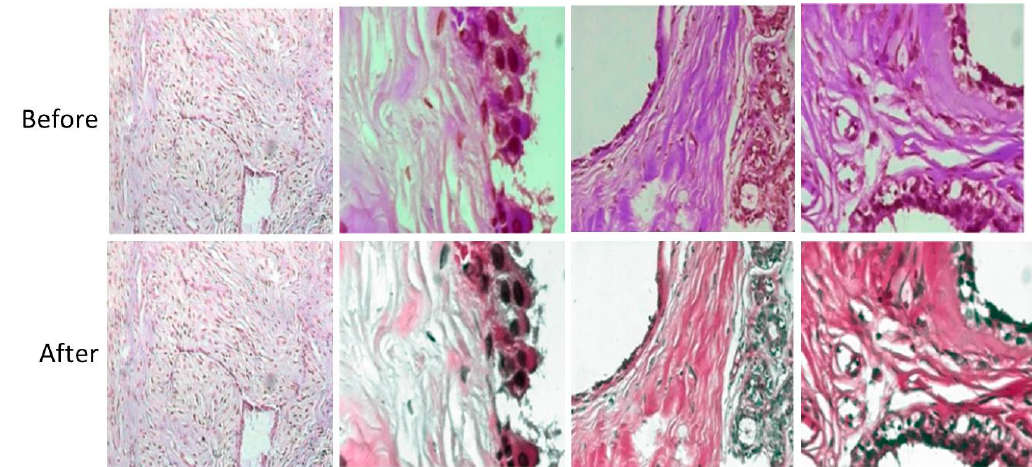
Figure 4. From the BreakHis dataset, the first row depicts benign 4 subclasses, while the second row shows malignant 4 subclasses. These images have a magnification factor of 200×. The illustration of stain normalized images is shown in Figure 5.